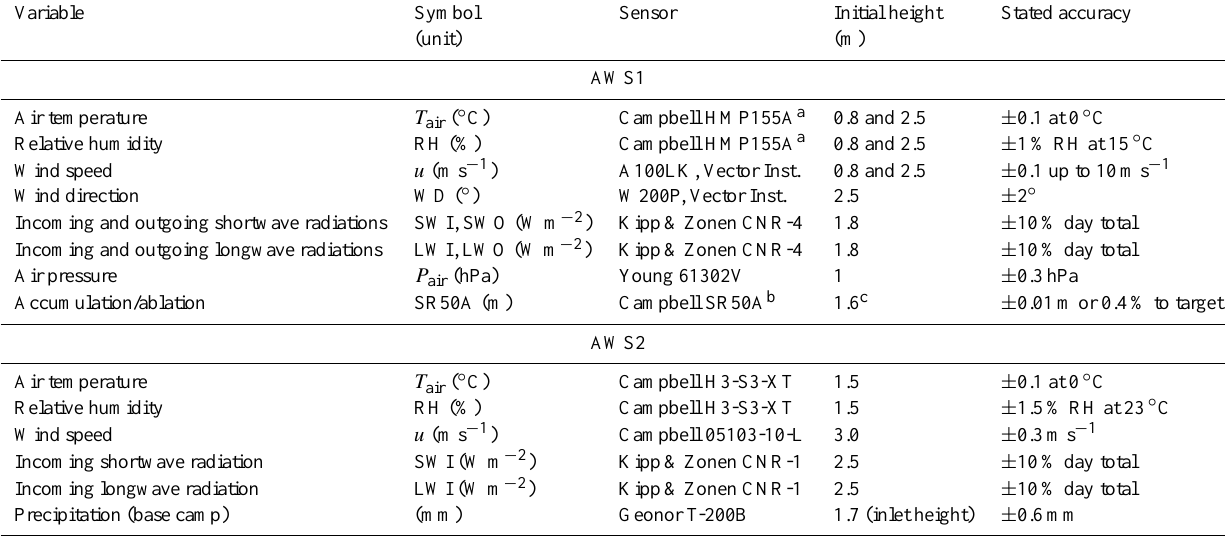
Table 1. Measurement specifications for AWS1 located at 4670ma.s.l. on the mid-ablation zone of Chhota Shigri Glacier, AWS2 located on a moraine at 4863ma.s.l., and precipitation gauge installed at base camp (3850ma.s.l.). Accumulation/Ablation at AWS1 was measured by SR50A sensor (Sect. 2.3). Variable symbols are also given. Sensor heights indicate the initial distances to the surface (12 August